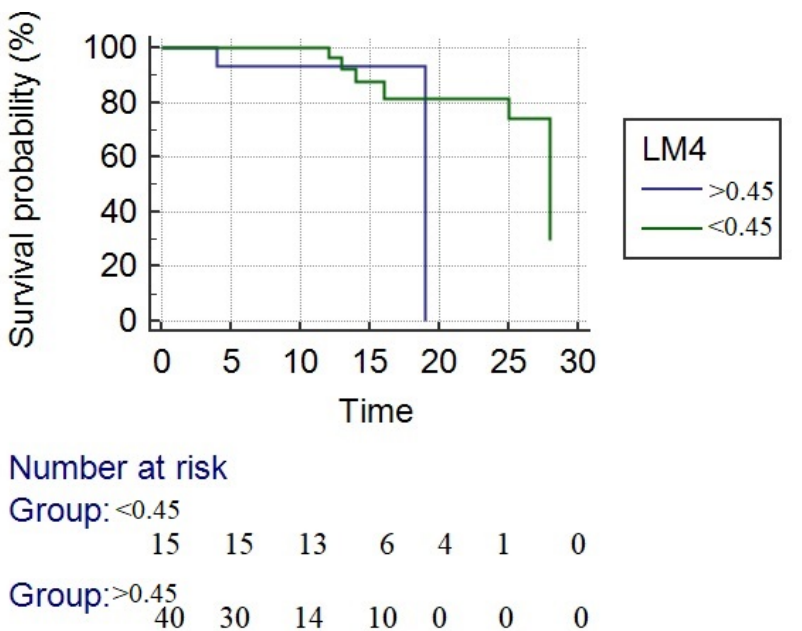
Figure 3. Kaplan–Meier survival analysis. The blue line represents the nonresponders, and the green line represents the responders to corticotherapy. The survival rate at 28 days in responders according to LM4 criteria was significantly higher compared with nonresponders (mean survival time—24.3 days vs. 18 days ( p = 0.04)).